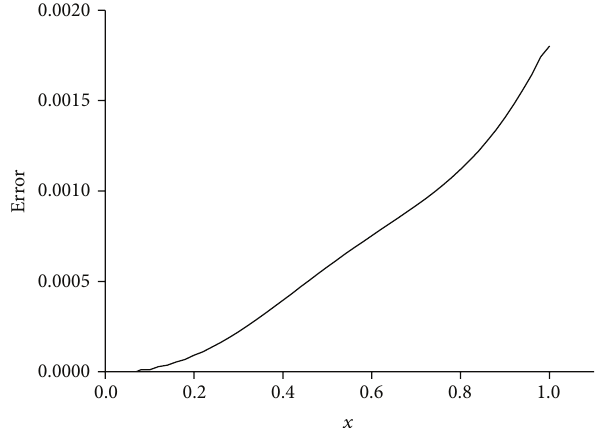
Figure 7: Errors for V = 0.01 , Δ𝑡 = 0.01 , ℎ = 0.02 , and 0 ≤ 𝑥 ≤ 1 .